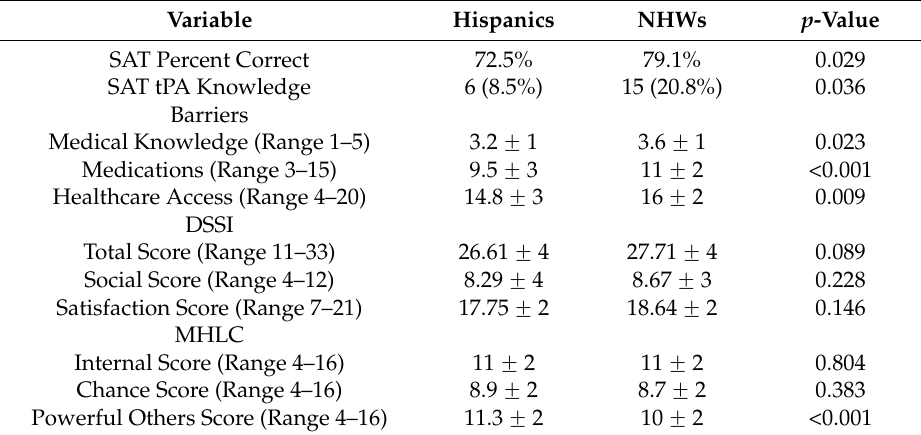
Table 2. Stroke participant survey results.